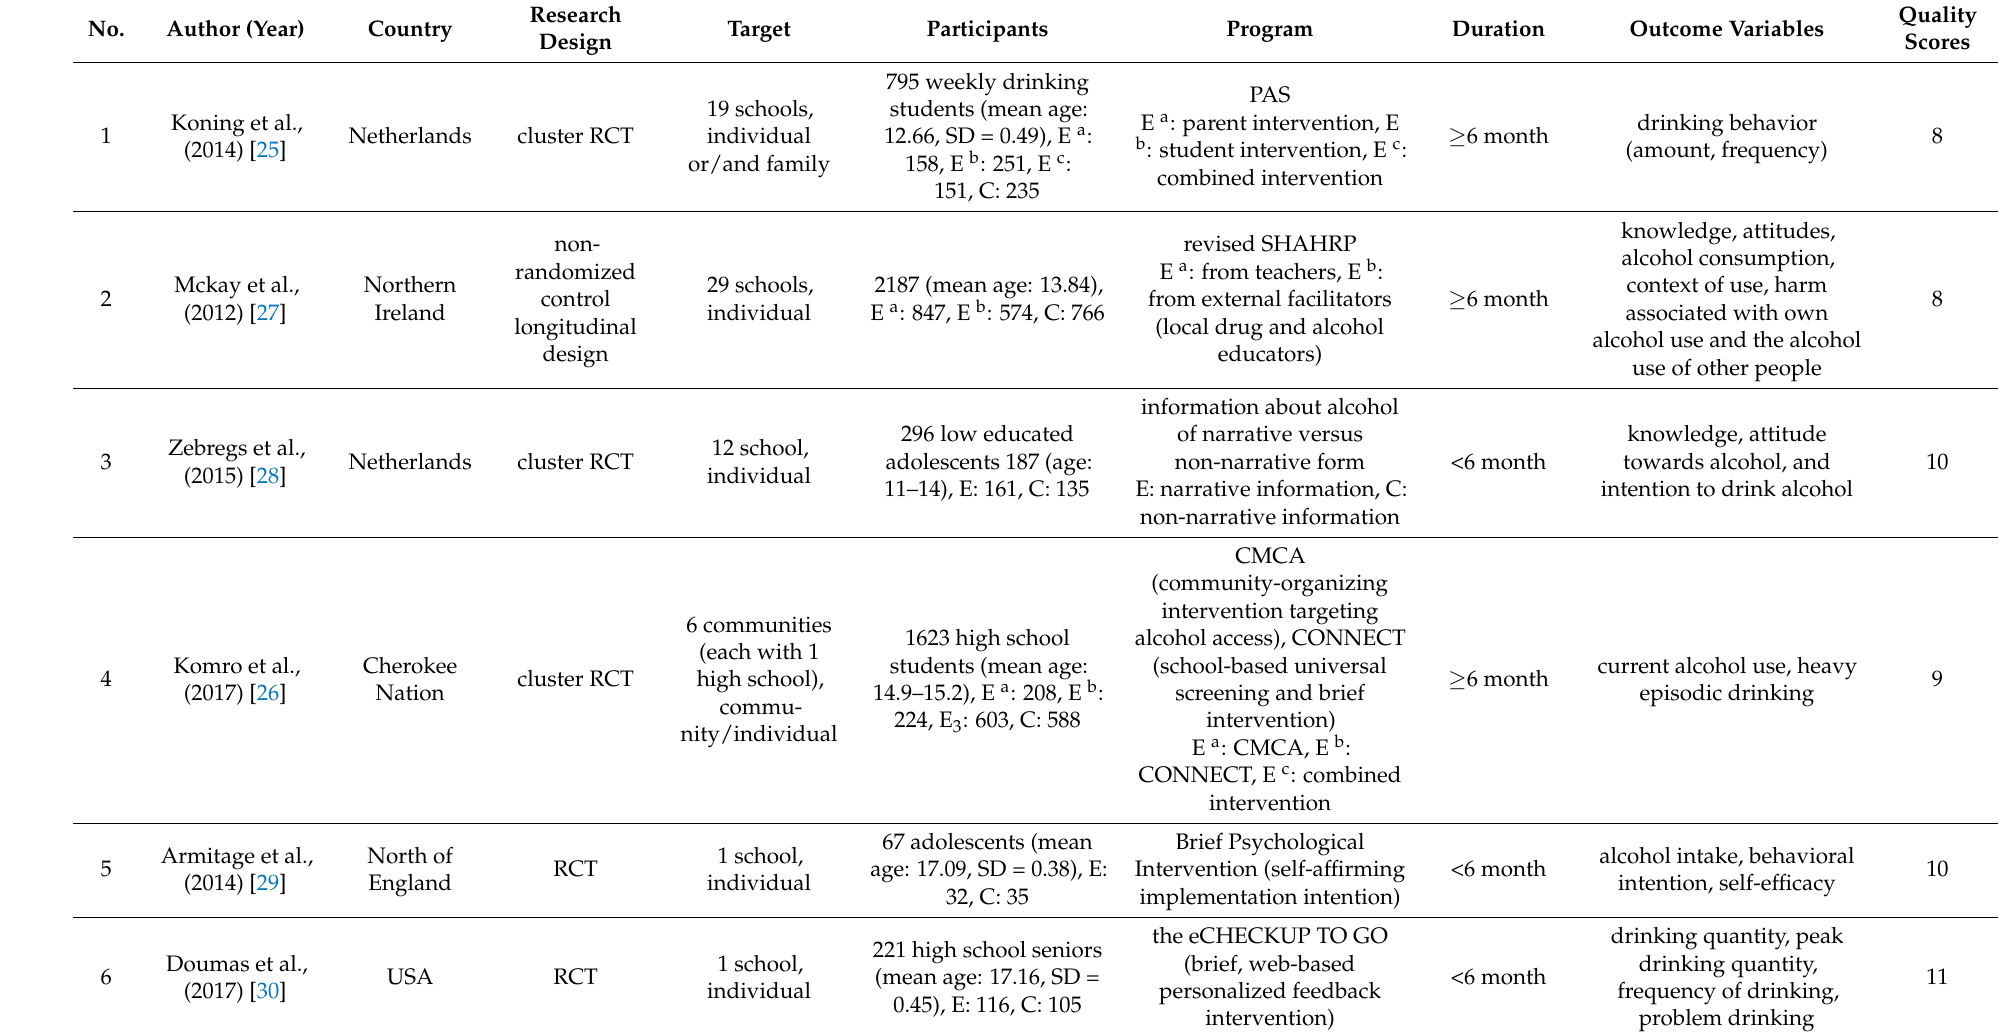
Table 2. Characteristics of the included